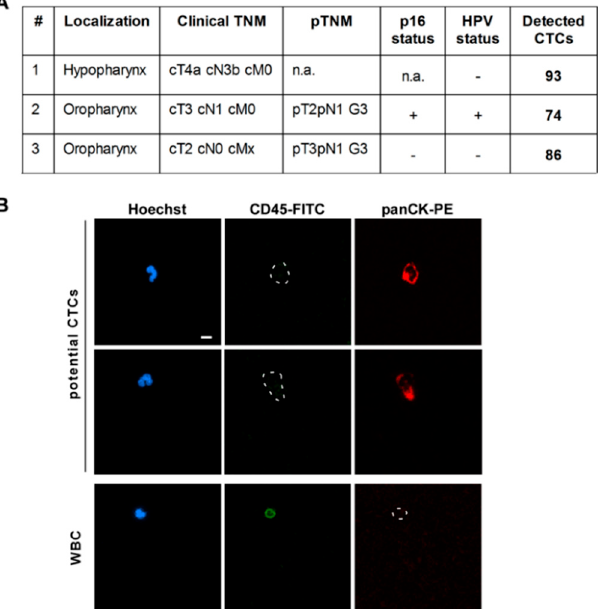
Figure 5. Potential circulating tumor cells (CTCs) could be enriched from head and neck cancer patient blood. ( A ) Clinical parameters and numbers of detected CTCs for three patients suffering from hypo- or oropharyngeal cancers including lymph node metastases. ( B ) 7.5 mL of patient blood was mixed with EpCAM-coupled T1 beads and placed into the IsoMAG unit for automatic enrichment of CTCs. For cell counting, enriched cells were stained with Hoechst dye, cytokeratin (panCK-PE), and CD45-FITC antibodies and quantified by fluorescence microscopy. [Hoechst+/CD45 − /panCK+] cells were classified as potential CTCs, [Hoechst+/CD45+/panCK − ] cells as leukocytes (WBC). Scale bar, 10 µm.